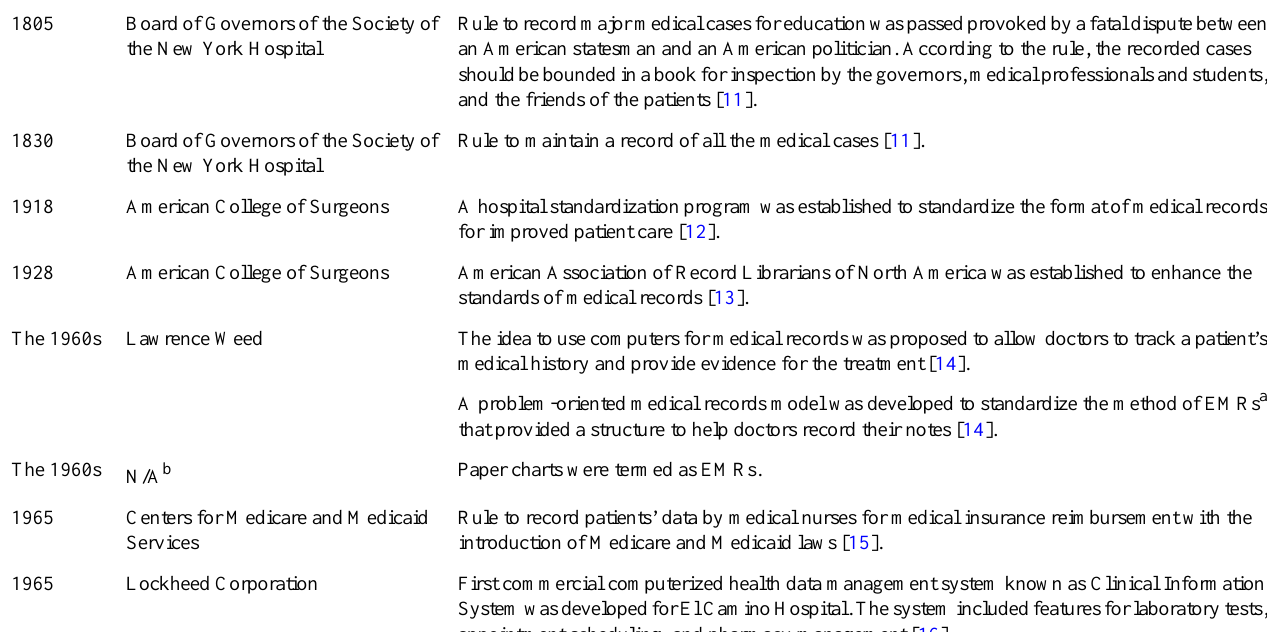
Evolutionary changeResponsible